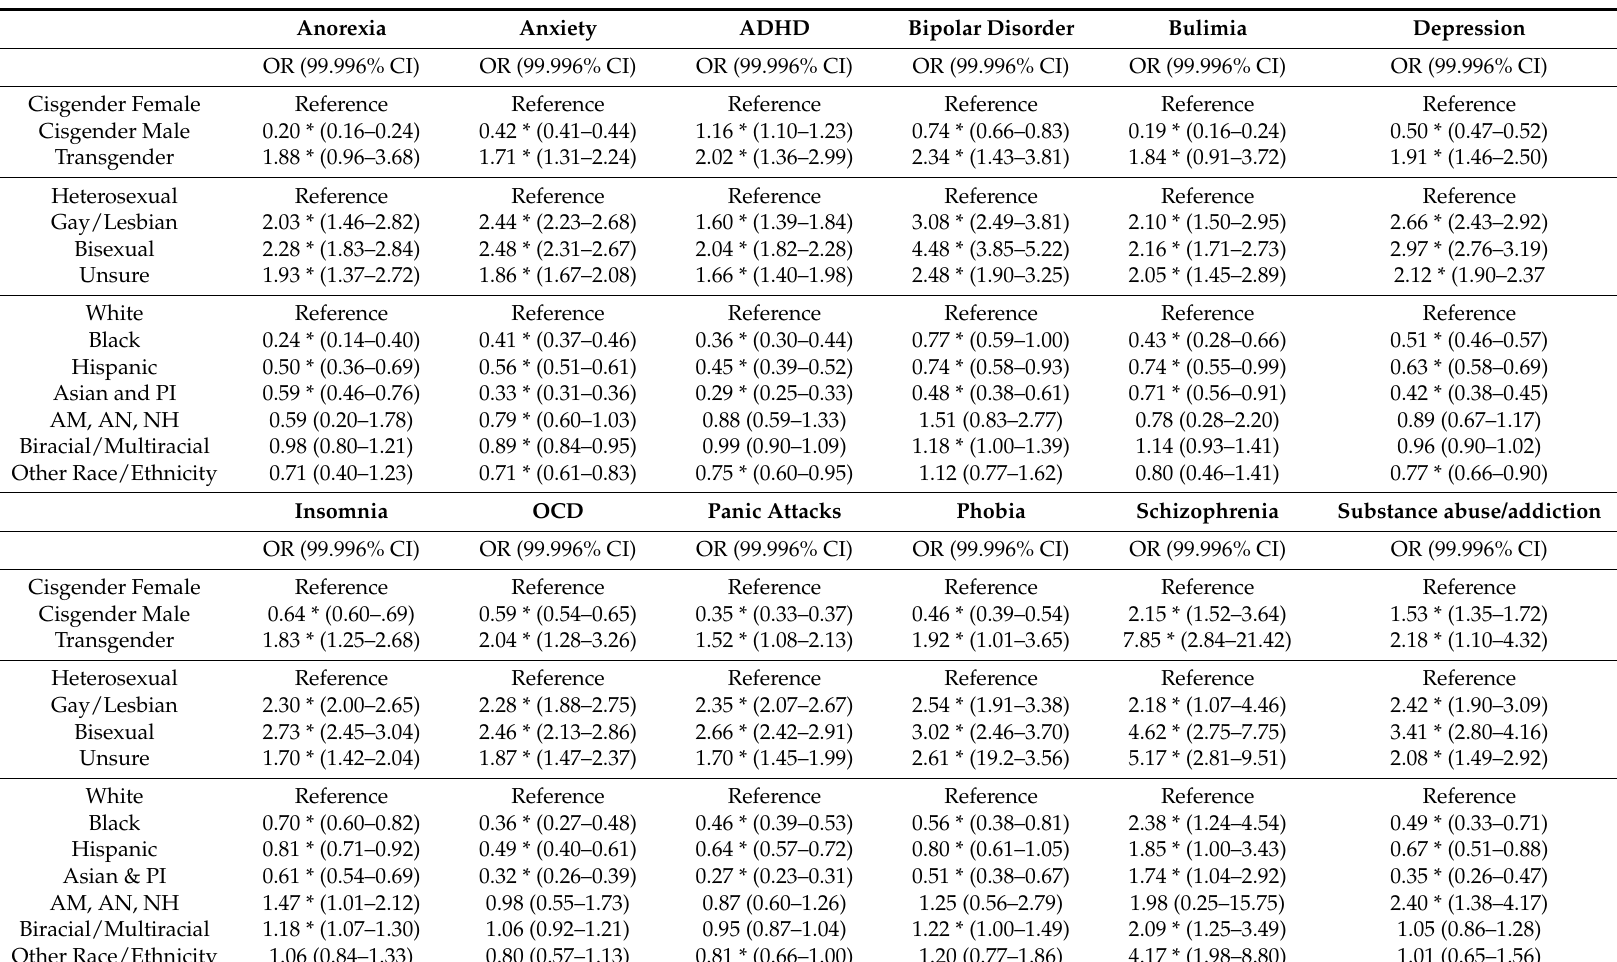
Table 2. Regression analyses for mental health